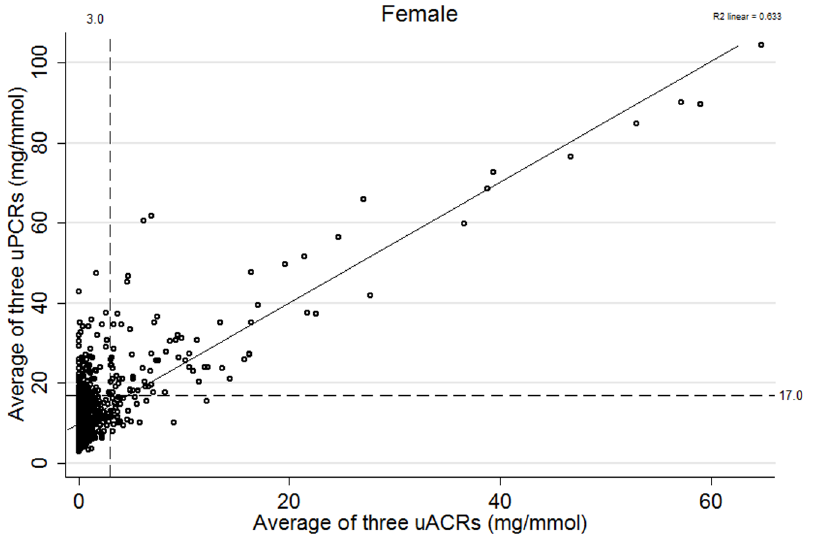
Figure 3. Scatterplot showing the distribution of uACR and uPCR relative to clinically important threshold values for females (excluding outlier values (ACR over 70 mg/mmol and PCR 150 mg/mmol)). Explanatory footnote for Figure 3: High values have been excluded (uACR . 70 mg/mmol and uPCR . 150 mg/mmol) to better illustrate the relationship at lower levels of proteinuria.